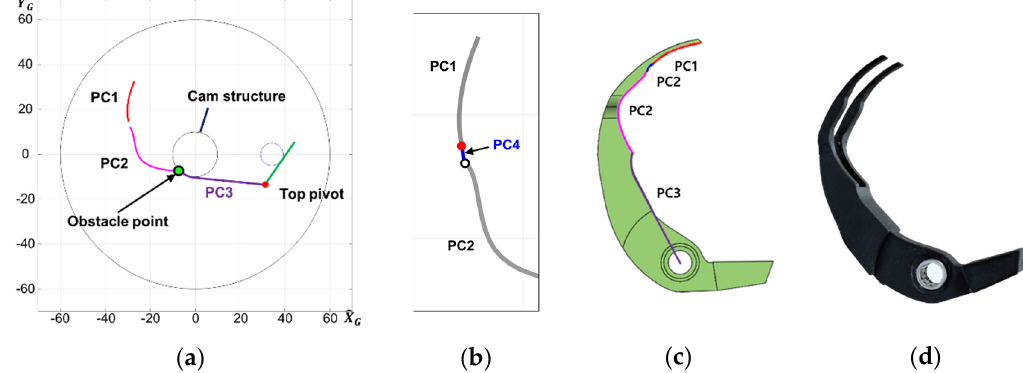
Figure 7. ( a ) Design of PC3 to avoid interference with the cam structure. The units of x - and y -axes are m; ( b ) design of PC3 to secure C1 continuity between PC1 and PC2; ( c ) final lever contour combining partial contours; ( d ) manufactured lever